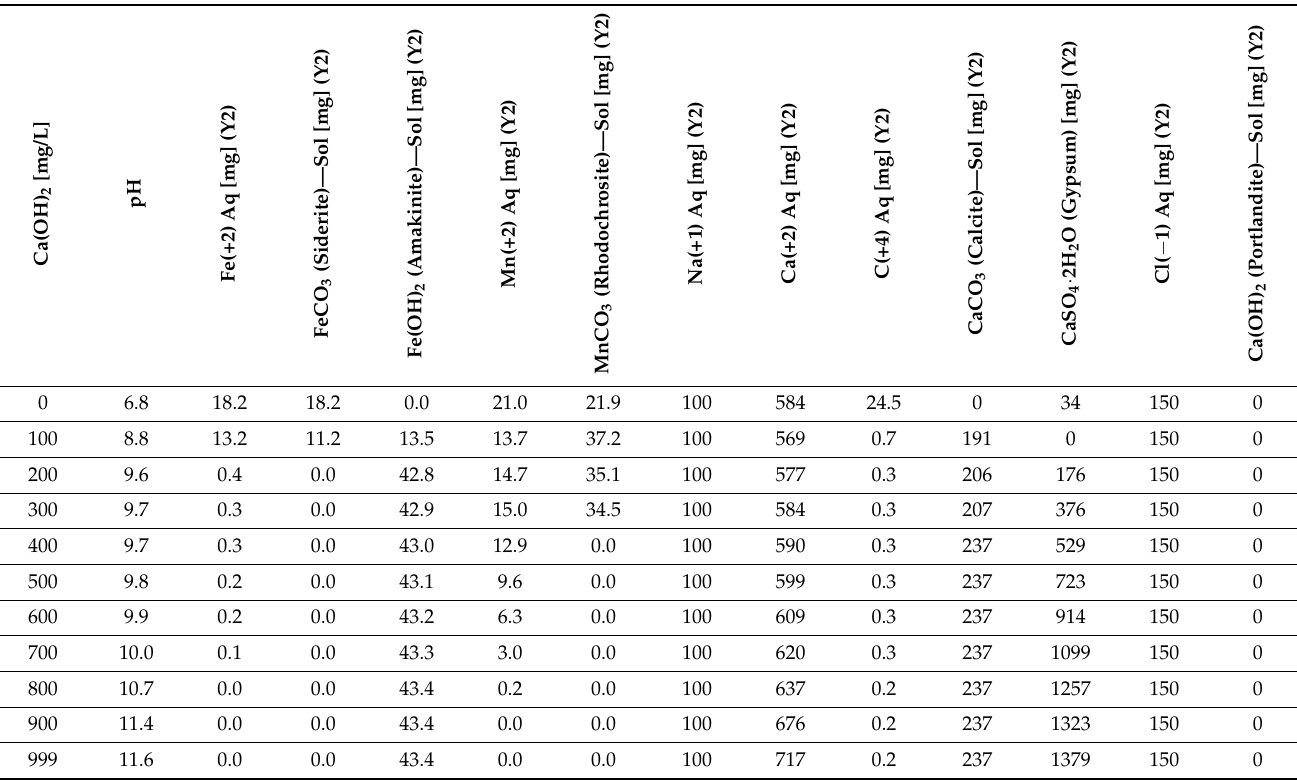
Table 7. Removal of remaining metals with Ca(OH) 2 after Fe 3+ removal with CaCO 3 (OLI